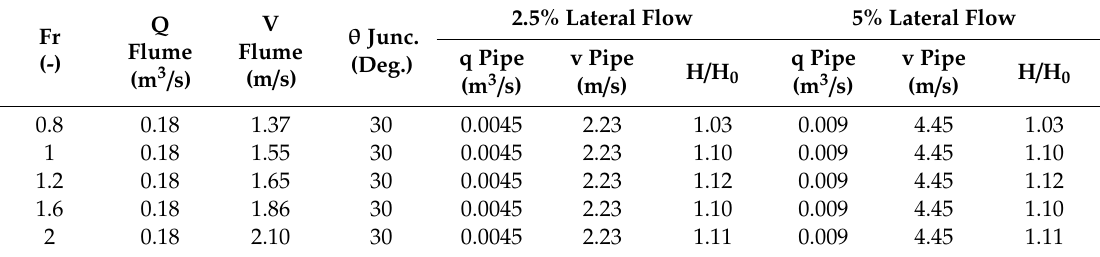
Table 7. Experimental results for the 30 ◦ junction in the wide